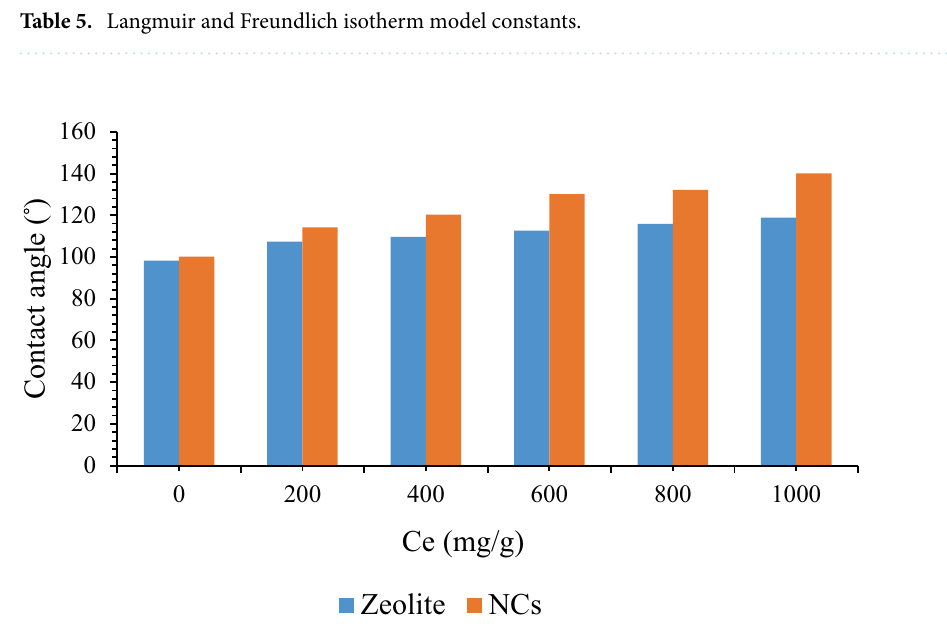
Figure 8. Contact angle before and after asphaltene adsorption at different asphaltene